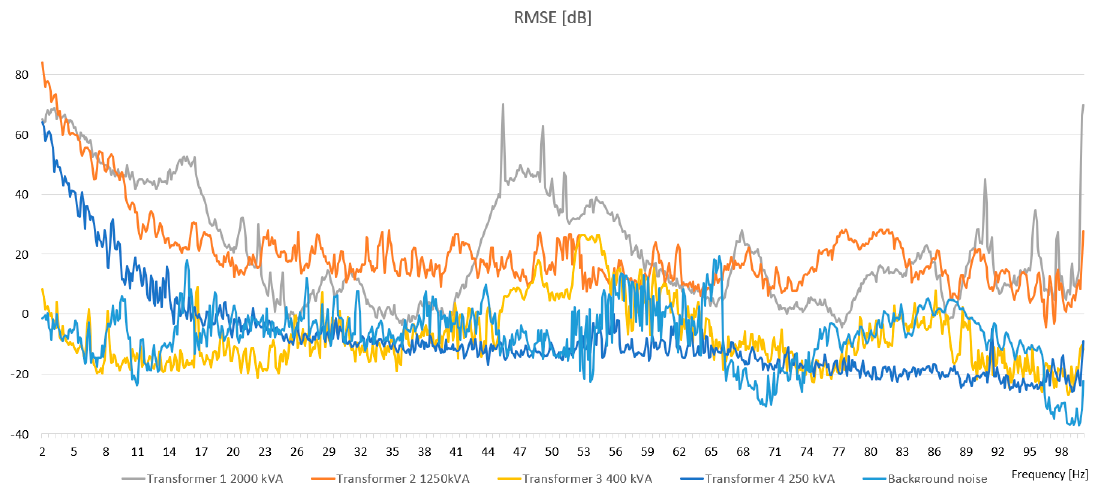
Figure 6. The rms pressure values of transformer noise in the 2–100 Hz frequency range.